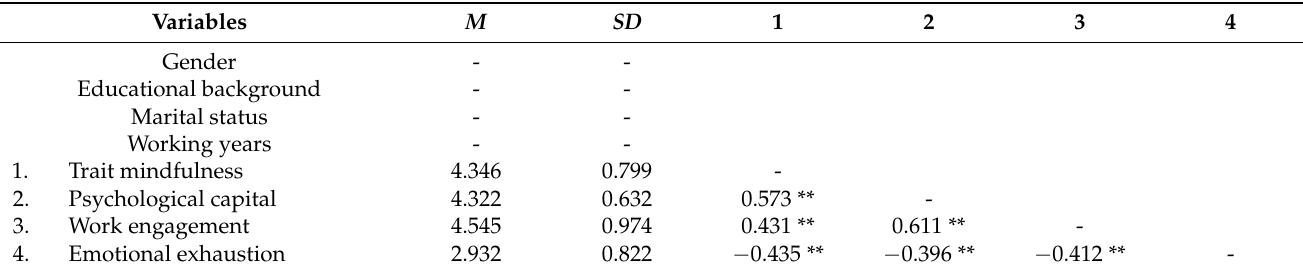
Table 2. Descriptive statistics and correlations among study variables ( N = 815).